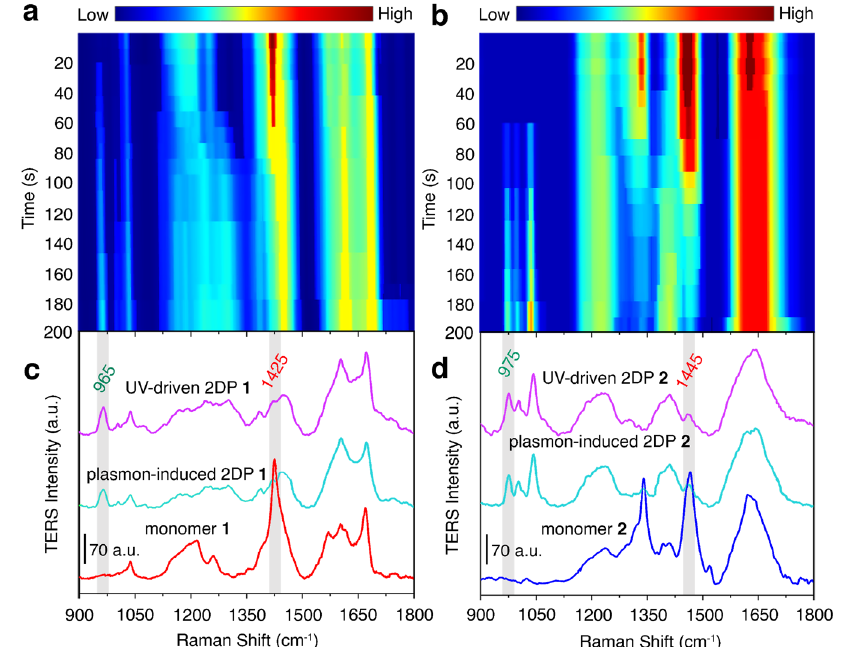
Fig. 2 In-situ TERS study of the plasmon-induced 2D polymerization. a , b Time-dependent TER spectral evolution of monomer a 1 and b 2 MLs in the STM-TERS nanogap (0.1 V, 0.1 nA) under laser excitation (633 nm, 0.3 mW). Serial TER spectra were acquired with an integration time of 10 s. c , d Typical TER spectra of the corresponding monomer and 2DP MLs under different conditions. a.u. arbitrary